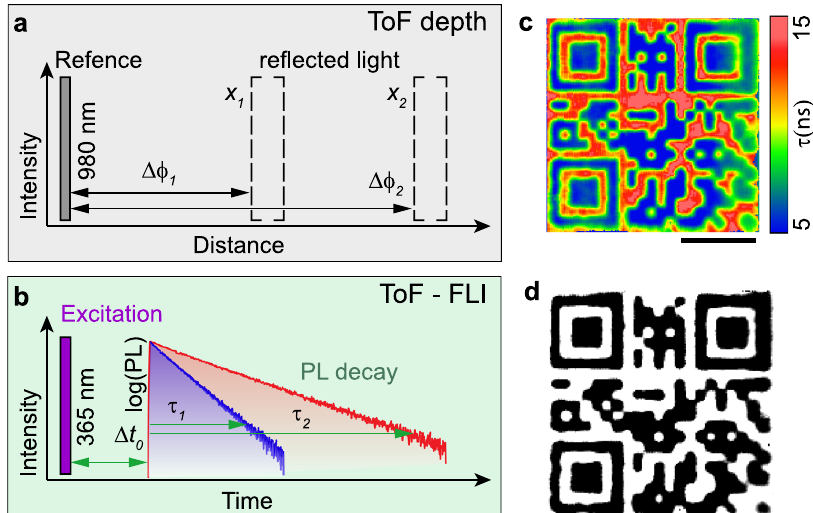
Fig. 6 ToF-FLI principle and imaging. a Principle for ToF-based LIDAR where x is distance and Δϕ is the corresponding change in phase. b The analogous approach for ToF-based TRPL where Δϕ is replaced by the fl uorescent lifetime, τ . c Lifetime pseudo-colour map of FLQR as recorded by the ToF-FLI imager (scale bar is 1 mm). d Black-and-white machine-readable QR code after binary-discretization of (e), Please try to scan it with your